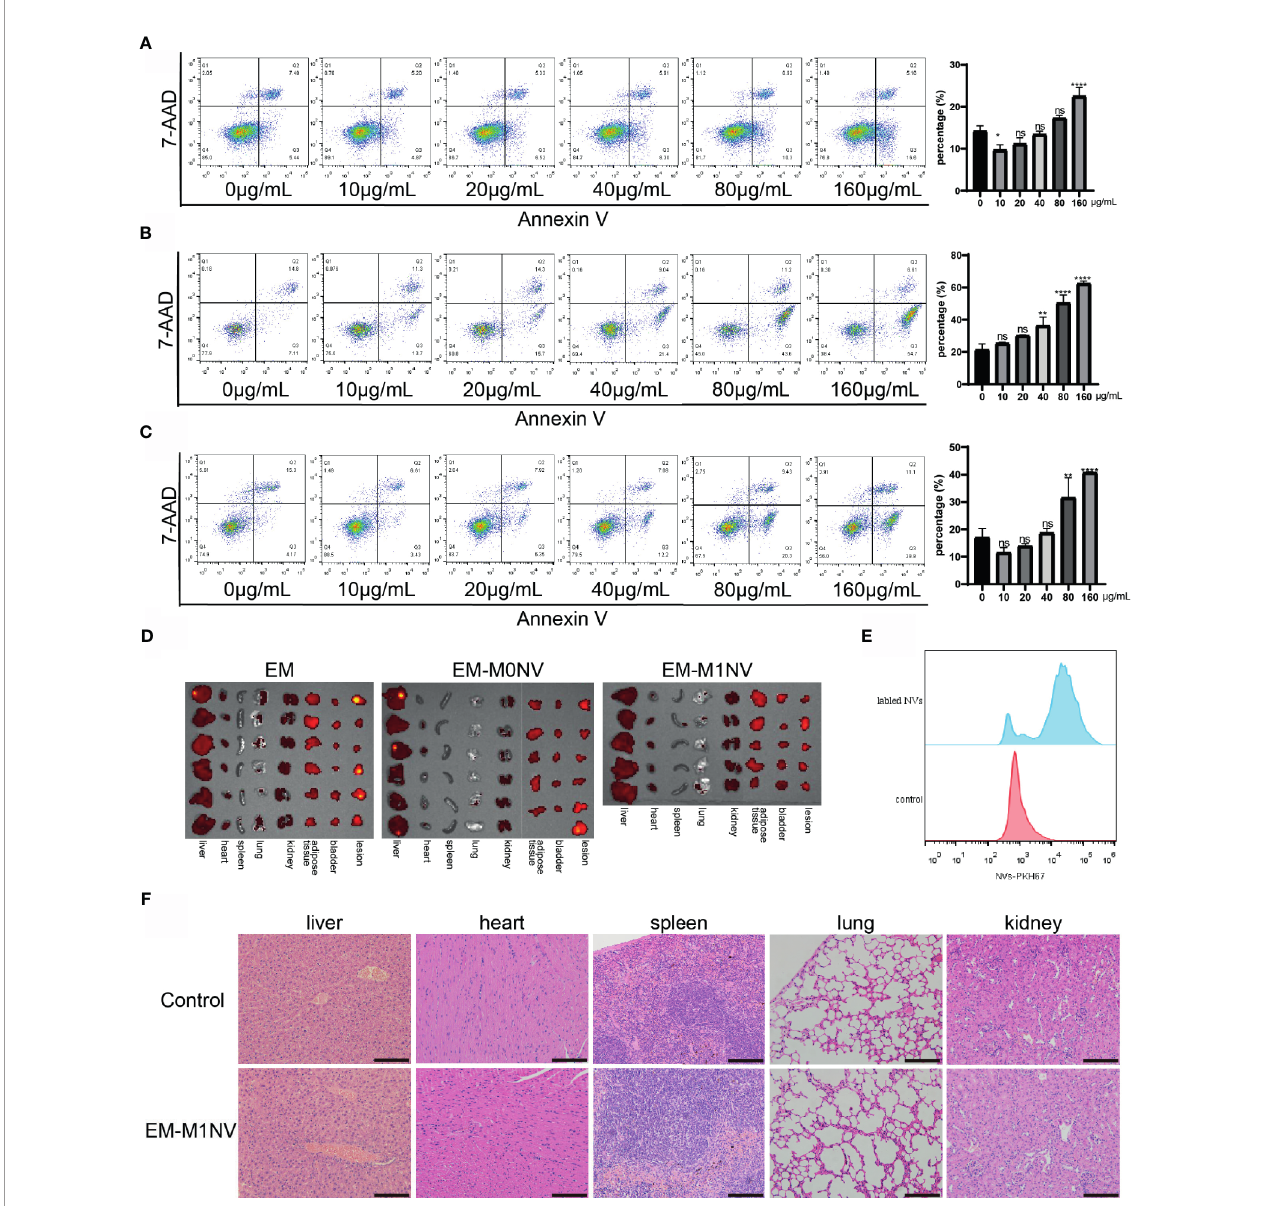
FIGURE 7 | M1NVs treatment did not induce cell apoptosis and did not injury the organs. (A) The apoptosis percentage of macrophages treated with different concentration of M1NVs. (B) The apoptosis percentage of ESCs treated with different concentration of M1NVs. (C) The apoptosis percentage of HUVECs treated with different concentration of M1NVs. ns, No signi fi cance when compared with the group treated with 0 m g/mL M1NVs. *P<0.05, **P<0.01, ****P<0.0001 when compared with group treated with 0 m g/mL M1NVs. (D) IVIS of the organs from different groups. Group EM was the negative control since no labeled NVs were injected. (E) FCM showed NVs labeled with PKH67 were engulfed by the peritoneal macrophages. (F) H&E staining sections of organs from control group and EM- M1NV group (Scale bar = 100 m